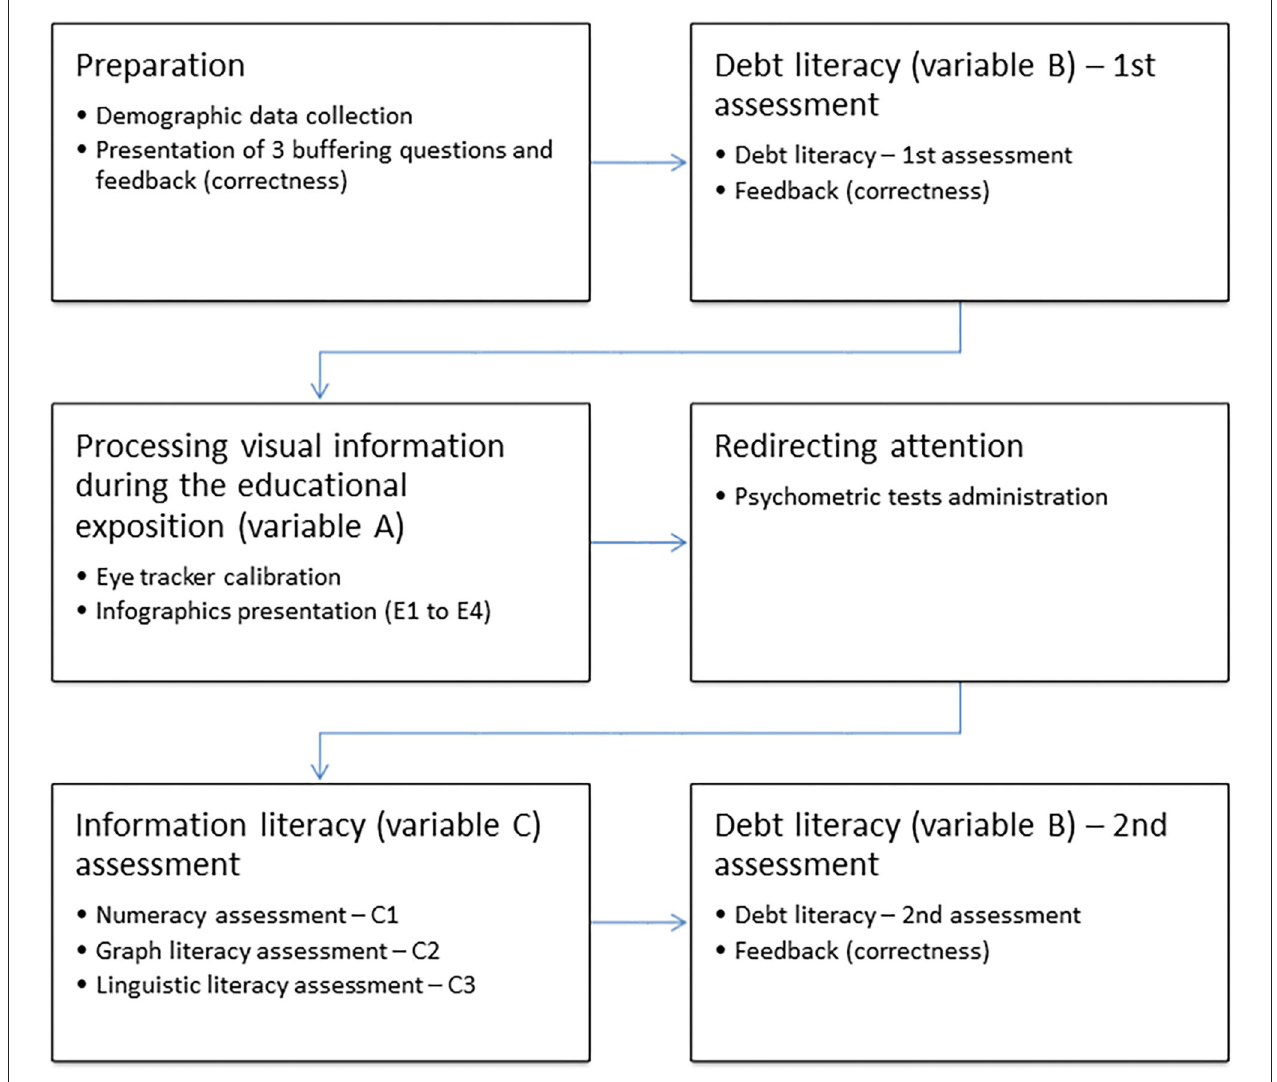
FIGURE 1 | The experiment